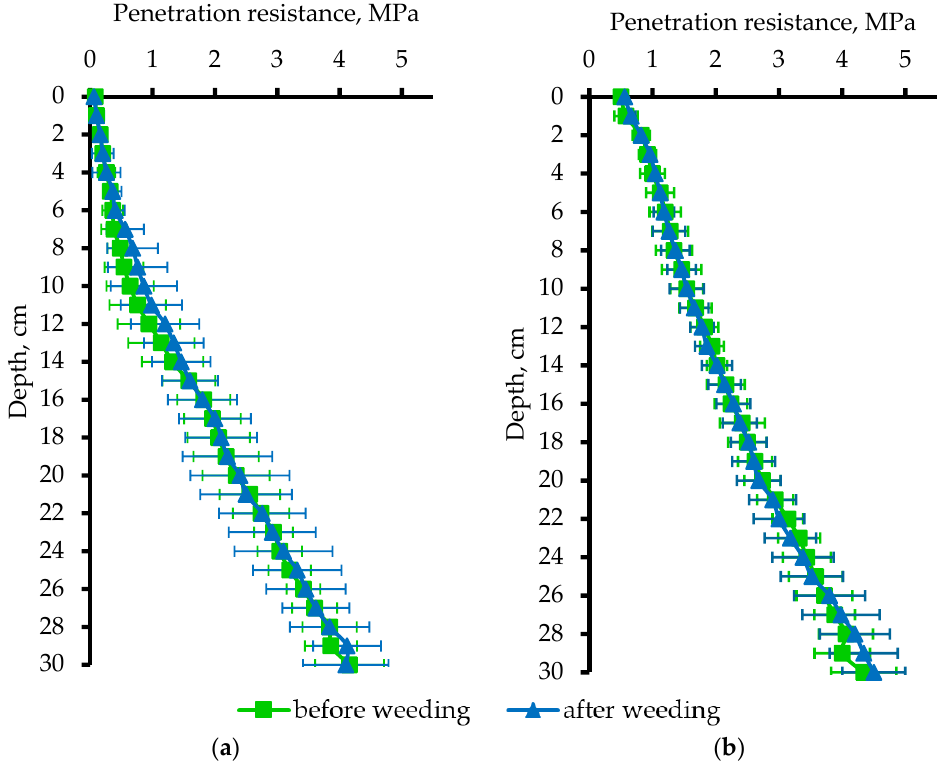
Figure 3. Soil penetration resistance before and after the weed control process: ( a ) CWC1 (25 May 2021); ( b ) RWC (1 July 2021).